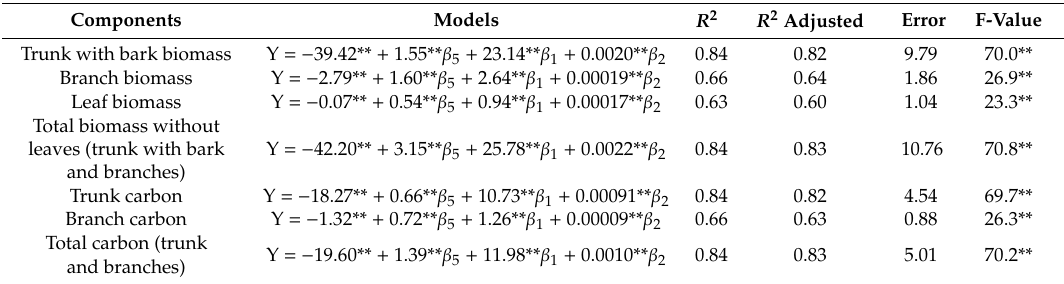
Table 7. Results of regression for biomass and carbon predictive equations in Mg / ha in short rotation Gmelina arborea plantations in two di ff erent locations in Costa